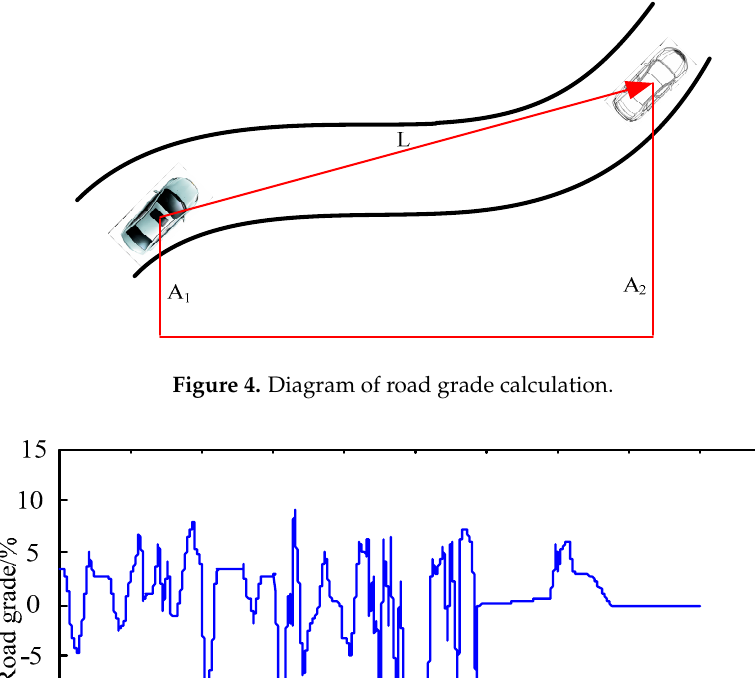
Figure 4. Diagram of road grade calculation.